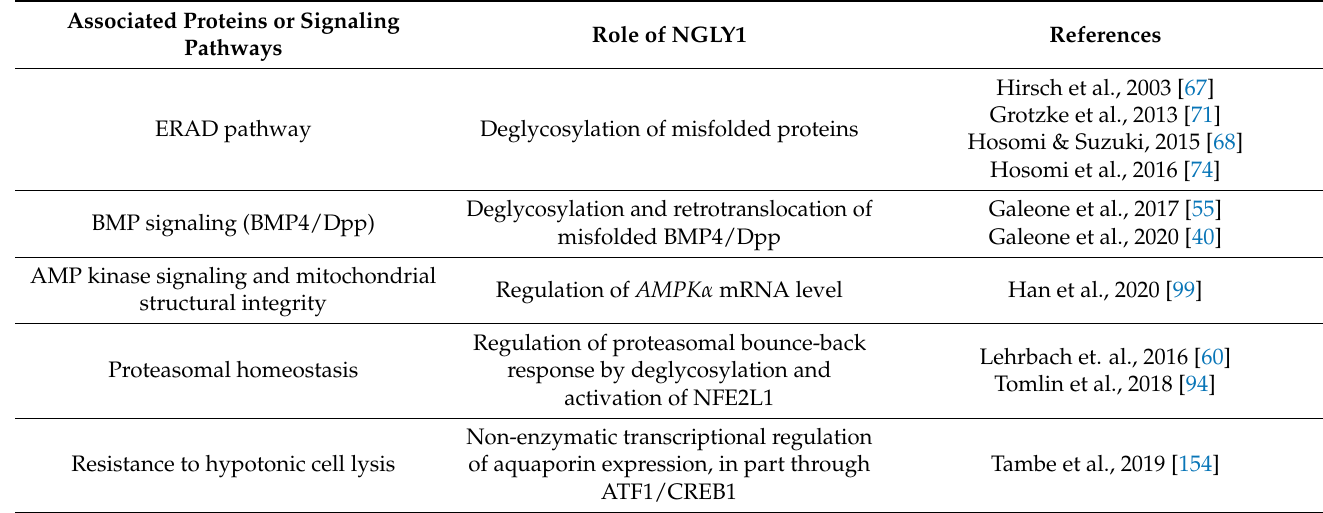
Table 2. List of the proteins and signaling pathways affected by NGLY1 deficiency in various model